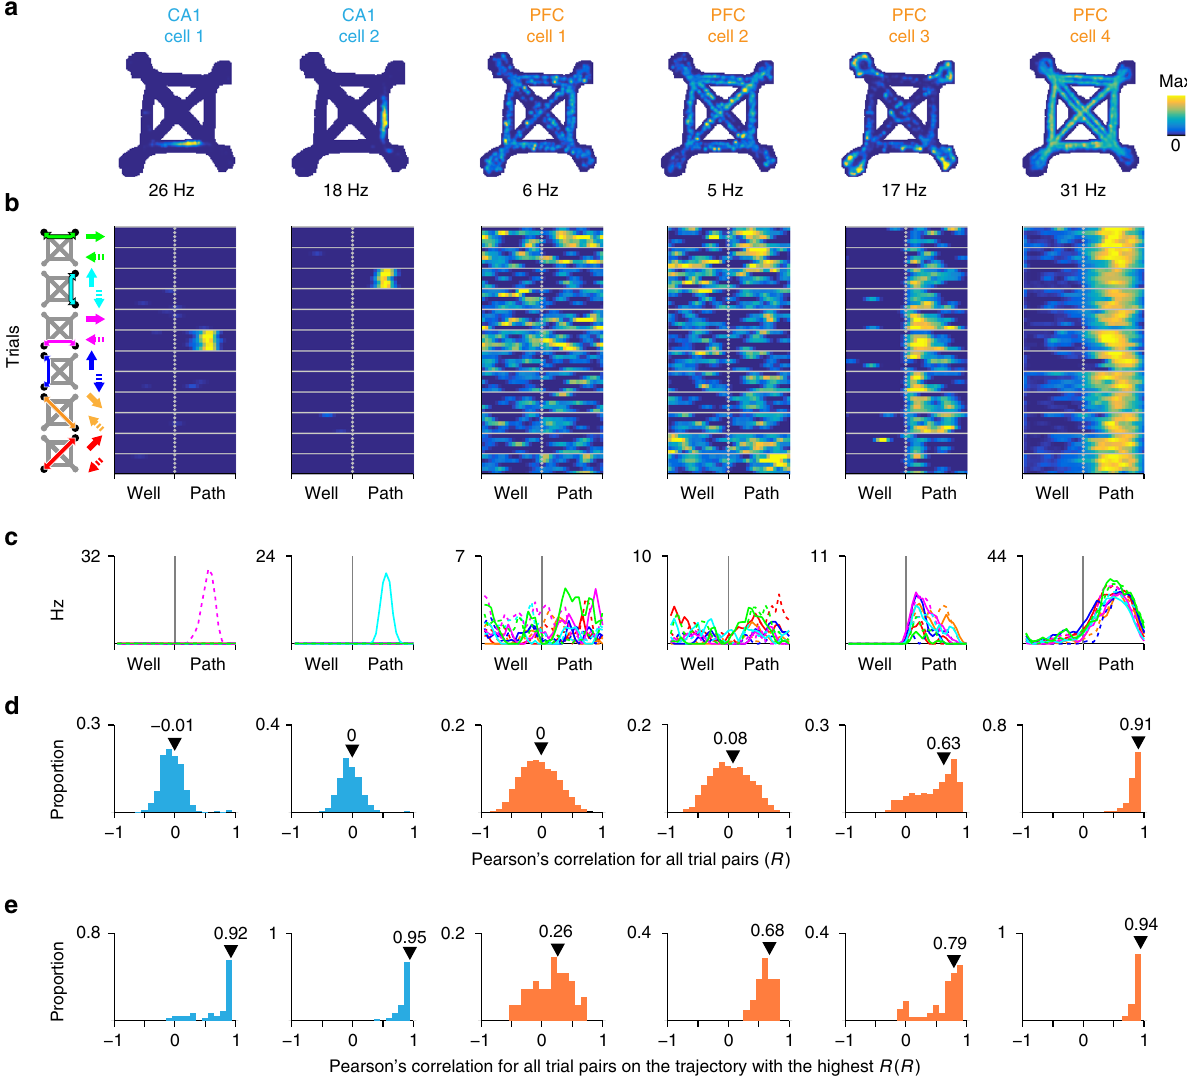
Fig. 1 Example CA1 and PFC task activity patterns. a Occupancy normalized spatial fi ring maps for 2 CA1 and 4 PFC cells that were simultaneously recorded. The maximum fi ring rate for each cell is indicated below each panel. b Time normalized trial fi ring rate maps for the cells in a . The vertical dotted line separates well and path trial phases. Horizontal solid lines separate trials on each trajectory. Five example trials are shown for each trajectory. The trajectory for each group of trials is indicated by the schematic to the left of column 1. Solid and dotted arrows indicate the two directions of travel on a path. The fi ring rate color scale is the same as in a – c . Median fi ring rate for each trajectory. Line color corresponds to arrow color scheme in b – d . Distribution of pairwise Pearson ’ s correlation for trial fi ring pro fi le across all trials. All-trial similarity ( R median ) is the median of the distribution and is indicated by the arrowhead. e Distribution of pairwise Pearson ’ s correlation for fi ring pro fi le of trials on the trajectory with the highest median pairwise correlation. Maximum within-trajectory similarity ( R max ) is the median of the distribution and is indicated by the